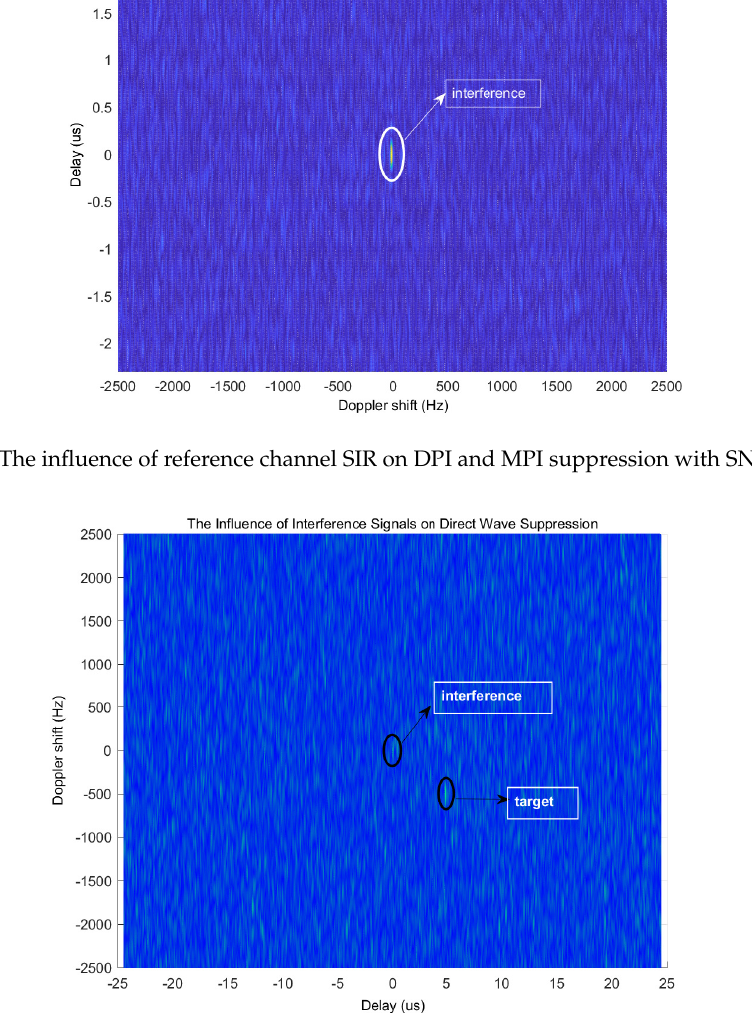
Figure 7. The influence of reference channel SIR on DPI and MPI suppression with SNR = 30